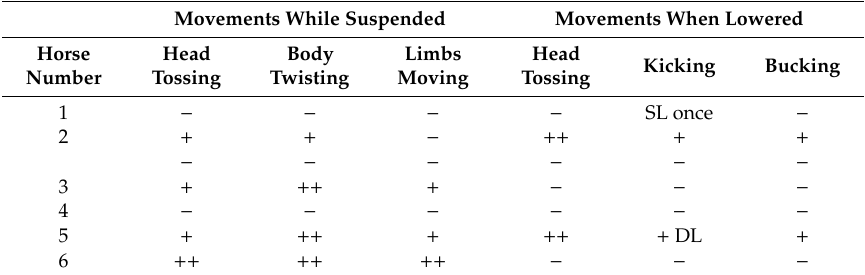
Table 2. Behavior observed during lifting with the Loop Vertical Lift System. The behavior observed is reported below—no motion, + 5–10 motions, ++ 10 or more motions. DL = double limb kick, SL = single limb.